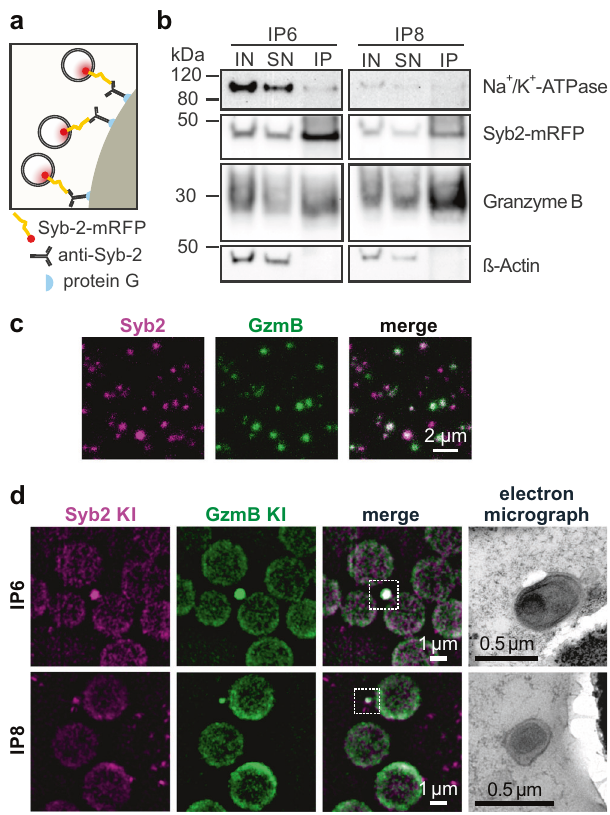
Fig. 2 Immuno-isolation of two classes of cytotoxic granules from CTLs using an anti-synaptobrevin2 (Syb2) antibody. a Scheme of Syb2-mRFP positive cytotoxic granules bound to the antibody-conjugated Dynabeads Protein G following immunoprecipitation (IP). b Representative western blots of IP6 and IP8 with input (IN, 2%), supernatant (SN, 2%) and IP (40%) volume. Protein markers for plasma membrane (Na + /K + -ATPase), cytotoxic granules (Syb2-mRFP, GzmB) and cytoskeleton ( β -actin) were used (N IP = 4). c 500 µ l of sucrose fraction 6 and 8 from Syb2/GzmB DKI CTLs were pooled and centrifuged on glass coverslip (N gradient = 1, n images = 3). The confocal images are shown as single channel (green and magenta) and merge image. d Correlative light and electron microscopy (CLEM) images of immuno-isolated organelles of Syb2/GzmB DKI CTLs (N IP = 1, n images = 7 and 4 for IP6 and IP8, respectively). Left to right: SIM fl uorescence images of IPs are shown for Syb2 (magenta) and GzmB (green), and the corresponding organelle is represented in the TEM images. Upper and lower panel represent IP6 and IP8, respectively. Source data are provided as a Source data fi